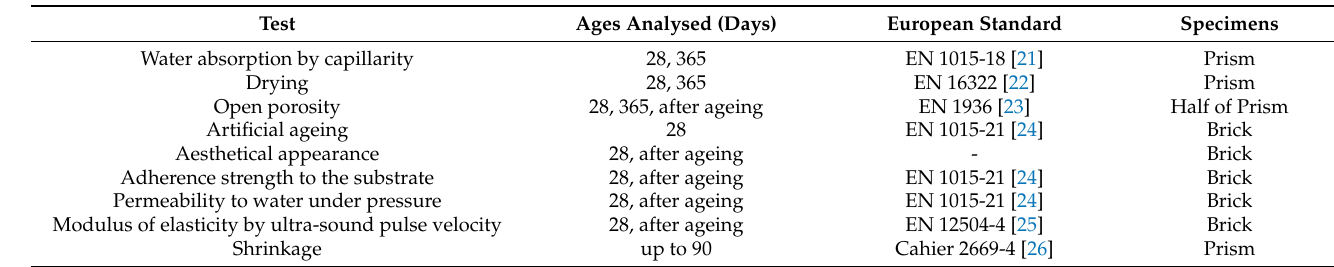
Table 1. Methods used for each